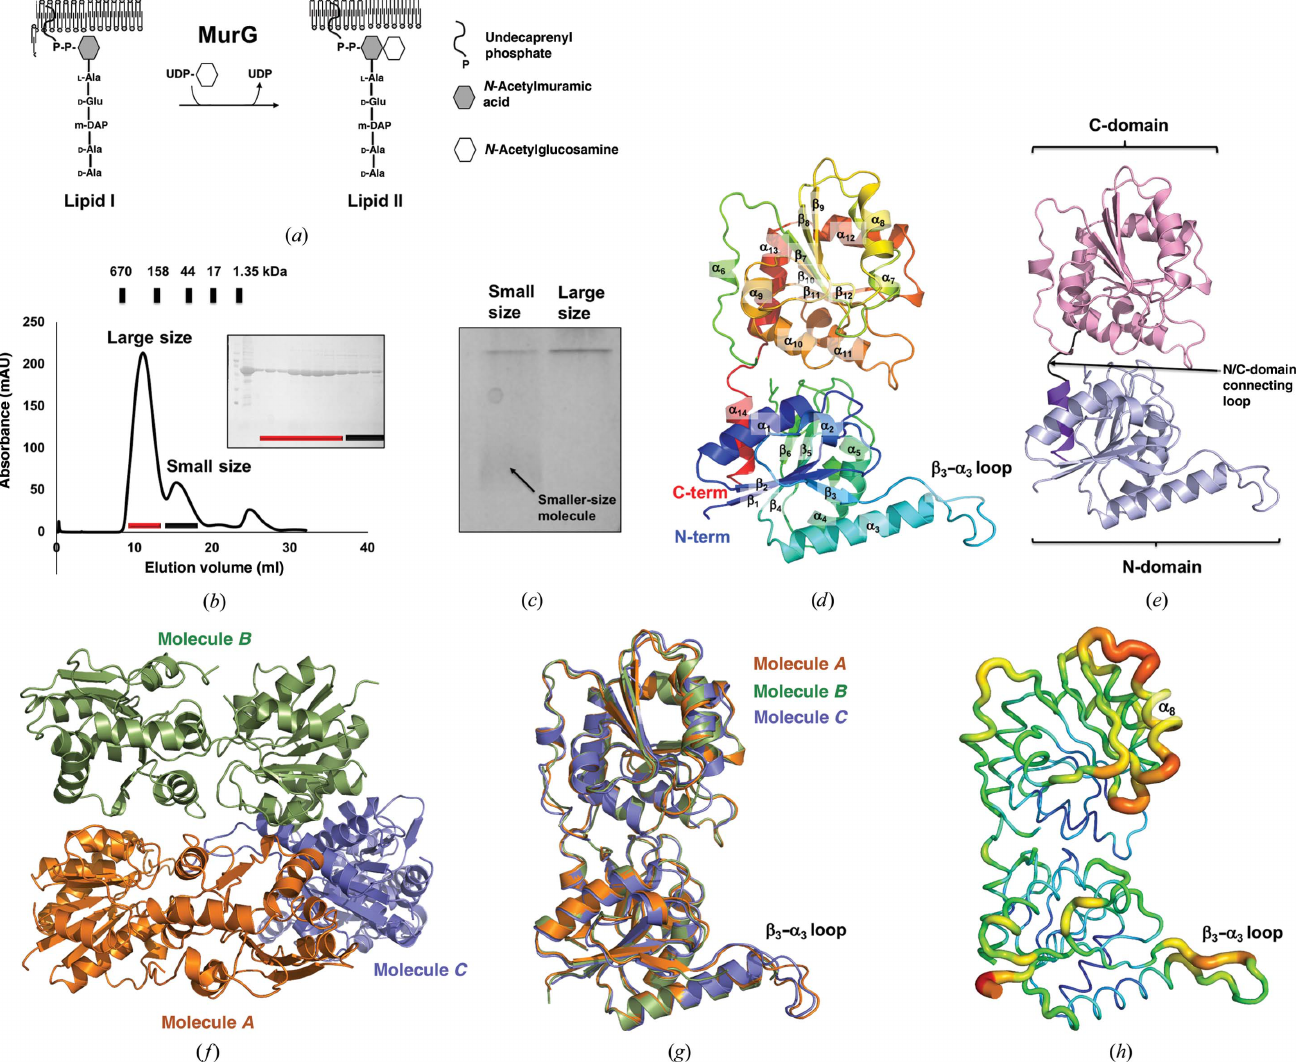
Figure 1 Crystal structure of abMurG. ( a ) Overview of the function of MurG. ( b ) Size-exclusion chromatography profile. Two peaks are labeled corresponding to an oligomer and a dimer. SDS–PAGE to assess the identity and purity is shown to the right of the two main peaks. The loaded fractions are indicated by black and red bars. ( c ) Native PAGE gel. The loaded samples are indicated above the gel. ( d ) Multi-colored cartoon representation of monomeric abMurG. The chain from the N- to C-terminus is colored from blue to red. Helices and sheets are labeled (cid:3) and (cid:2) , respectively. ( e ) A cartoon representation of the structure of abMurG showing the domain boundary in the structure. ( f ) Cartoon representation of the three abMurG molecules in an asymmetric unit. ( g ) Superposition of the structures of the molecules found in one asymmetric unit. ( h ) Putty representation showing the B -factor distribution. Rainbow colors from red to violet with increasing B -factor values were used for B -factor